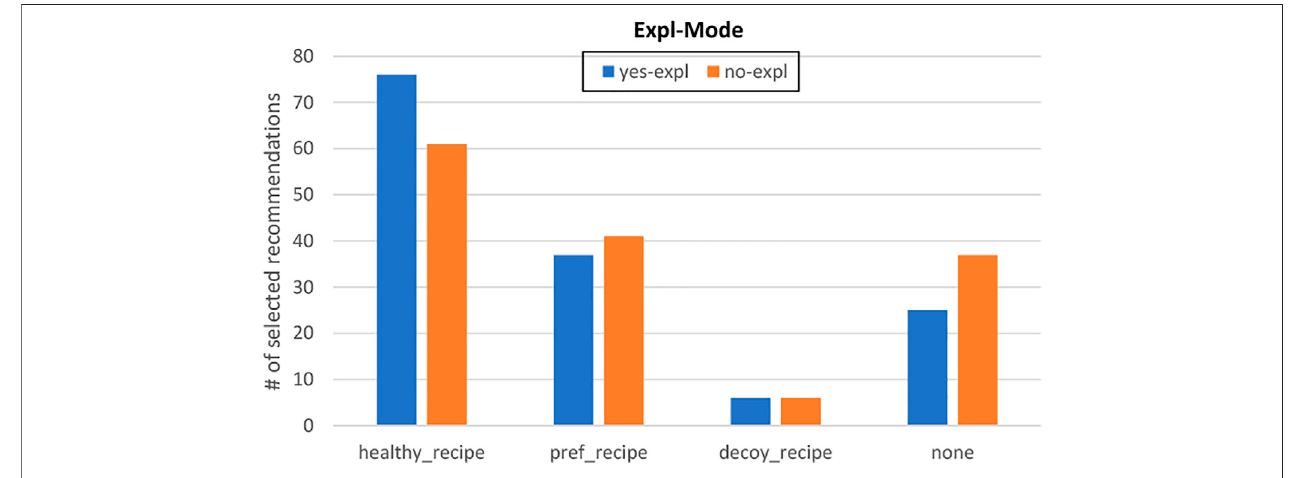
FIGURE 5 | In fl uence of the explanation mode on accepted recommendations.